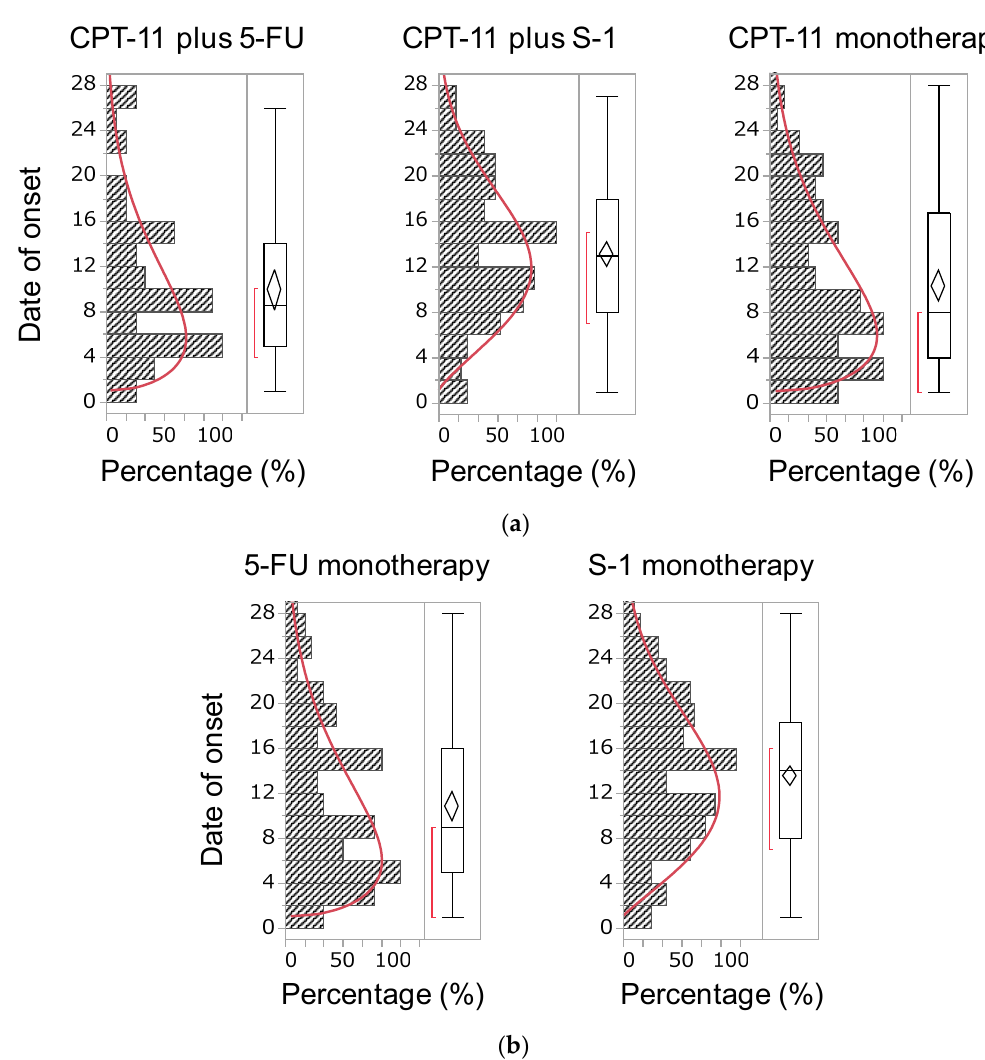
Figure 2. ( a ) Histogram and the Weibull shape parameter of the time of onset of diarrhea by an irinotecan (CPT-11)-containing regimen. The X-axis shows the percentage of the maximum frequency of diarrhea. The maximum frequency of diarrhea was 11, 22 and 19 for CPT-11 plus 5-FU, CPT-11 plus S-1 and CPT-11 monotherapy, respectively. The Y-axis shows the number of days of initial diarrhea after administration of the suspected medicine. The red line shows the Weibull shape parameter of diarrhea. ( b ) Histogram and the Weibull shape parameter of the time of onset of diarrhea by 5-fluorouracil (5-FU) or S-1. The X-axis shows the percentage of the maximum frequency of diarrhea. The maximum frequency of diarrhea was 20 and 32 for 5-FU monotherapy and S-1 monotherapy, respectively, whereas the Y-axis shows the number of days of initial diarrhea after administration of the suspected medicine. The red line shows the Weibull shape parameter of diarrhea. Table 5. Median onset of diarrhea induced by chemotherapy regimens.